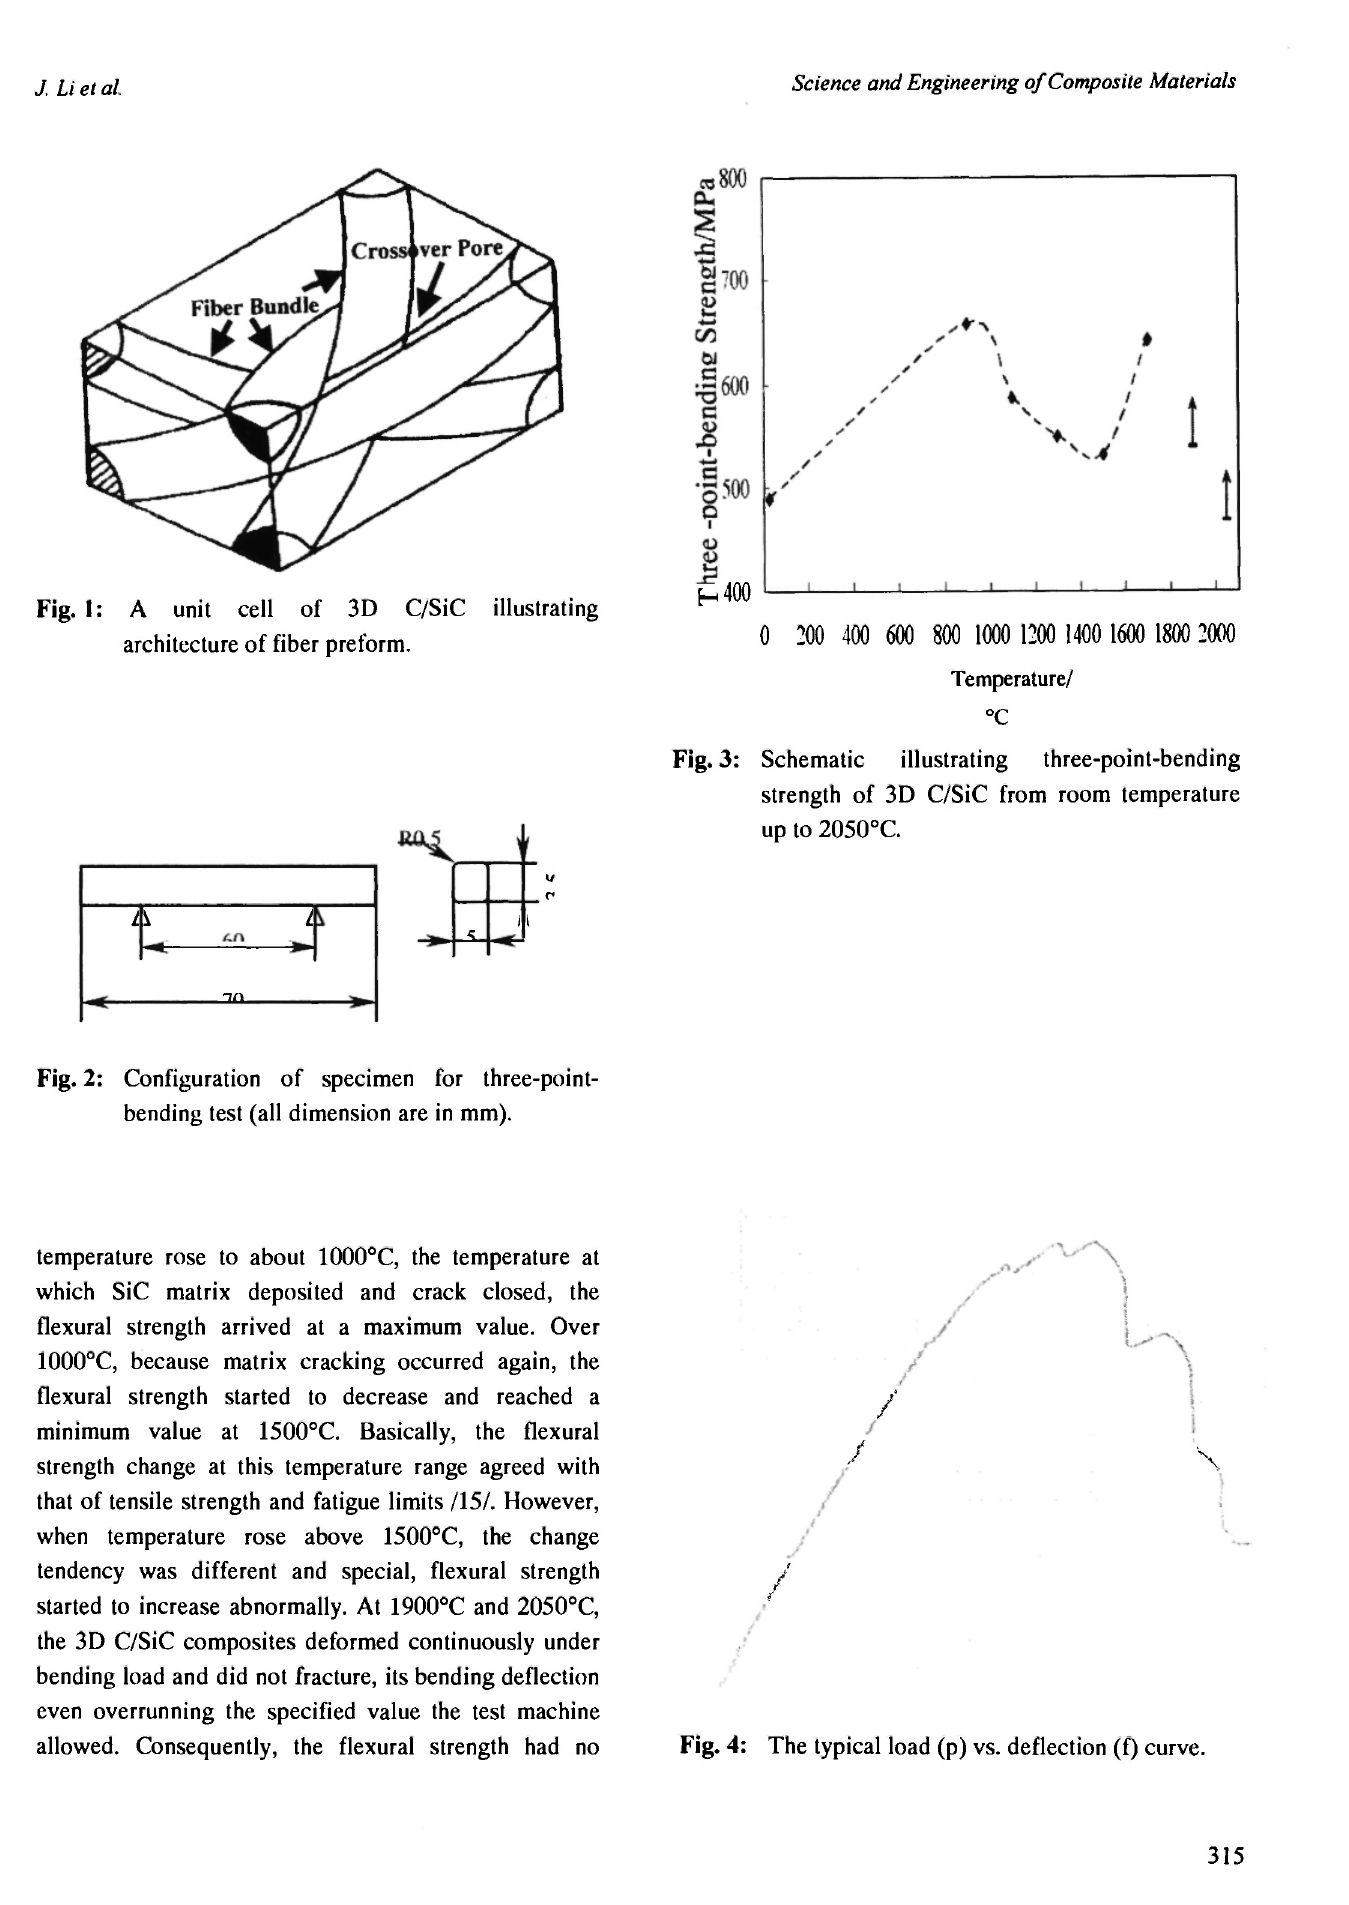
The typical load (p) vs. deflection (f)